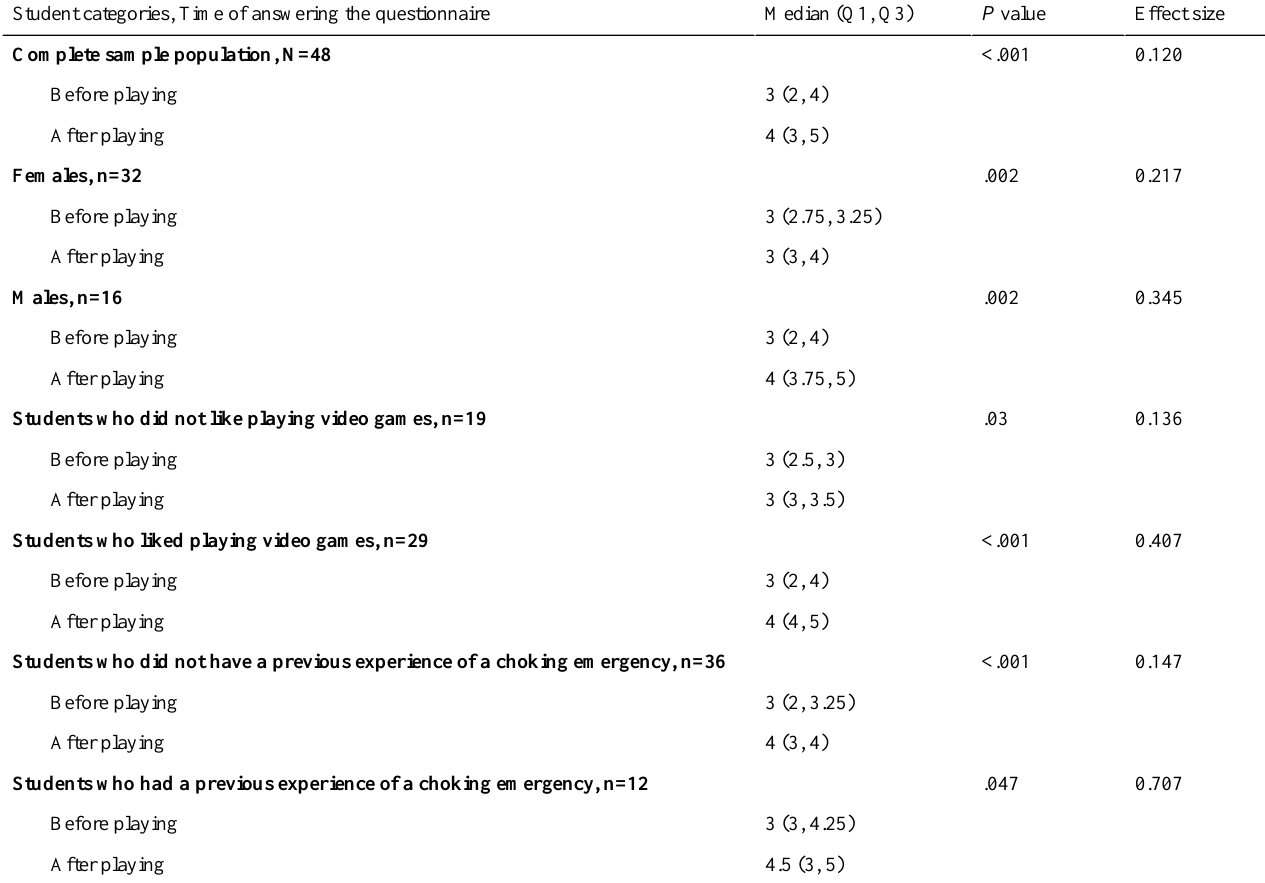
Table 5. Self-impression of the knowledge of the choking protocol before and after playing the game (grades from 1 to